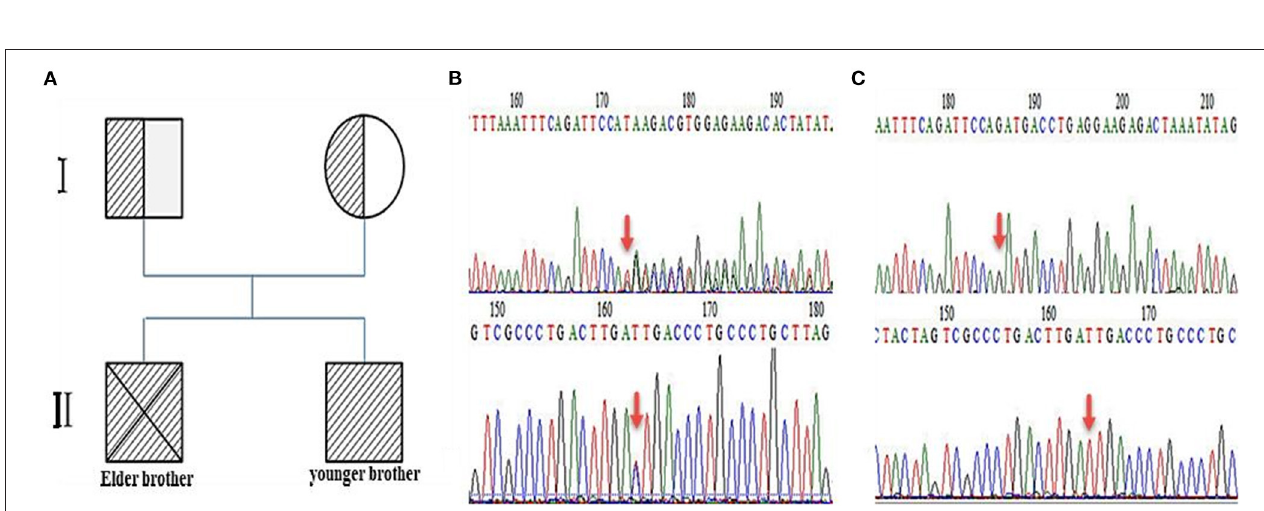
FIGURE 2 | Analysis of ZS inheritance. (A) The family tree shows that the parents are gene carriers, the elder brother died, and the younger brother survived. (B) DNA sequence analyses show two mutation sites (red arrows) before transplantation, in (top) exon6: c.1246_1247 delGA (p.D416) and (bottom) exon19: c.2966T > C